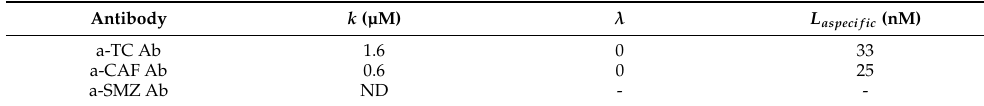
Table 4. Parameters obtained from data fitting of the equilibrium filtration test for the interaction of antibodies with their target antibiotics. ND: not determined.